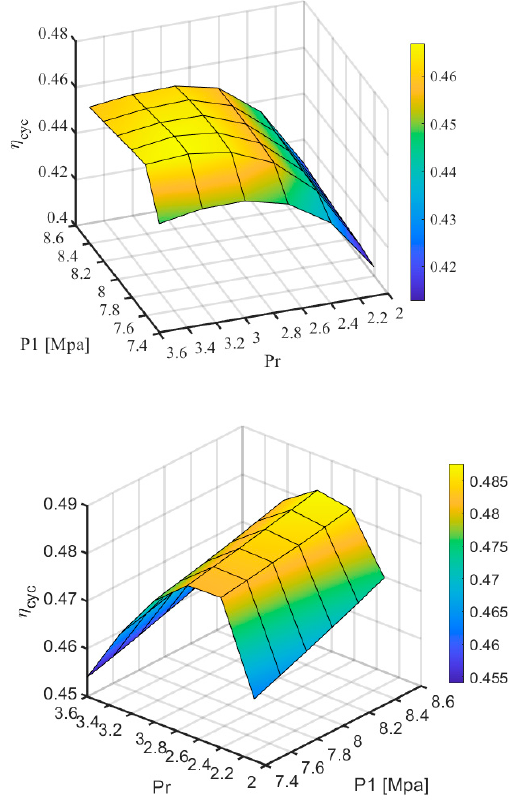
Figure 10. Deviation of η cyc with P 1 and Pr .